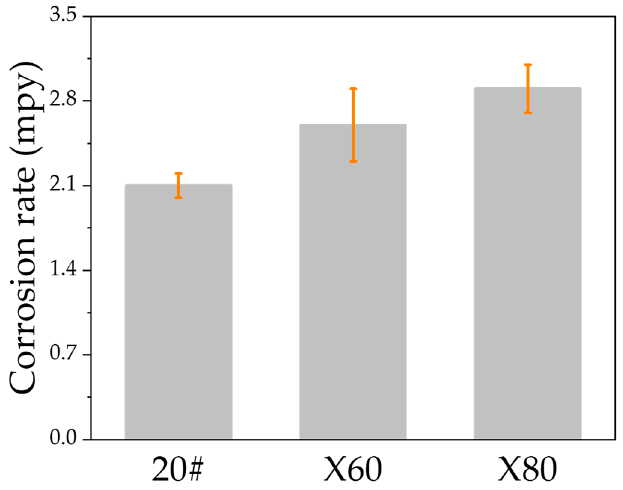
Figure 5. The SEM micrograph of 20# ( a ), X60 ( b ), and X80 ( c ) steels after the polarization test.